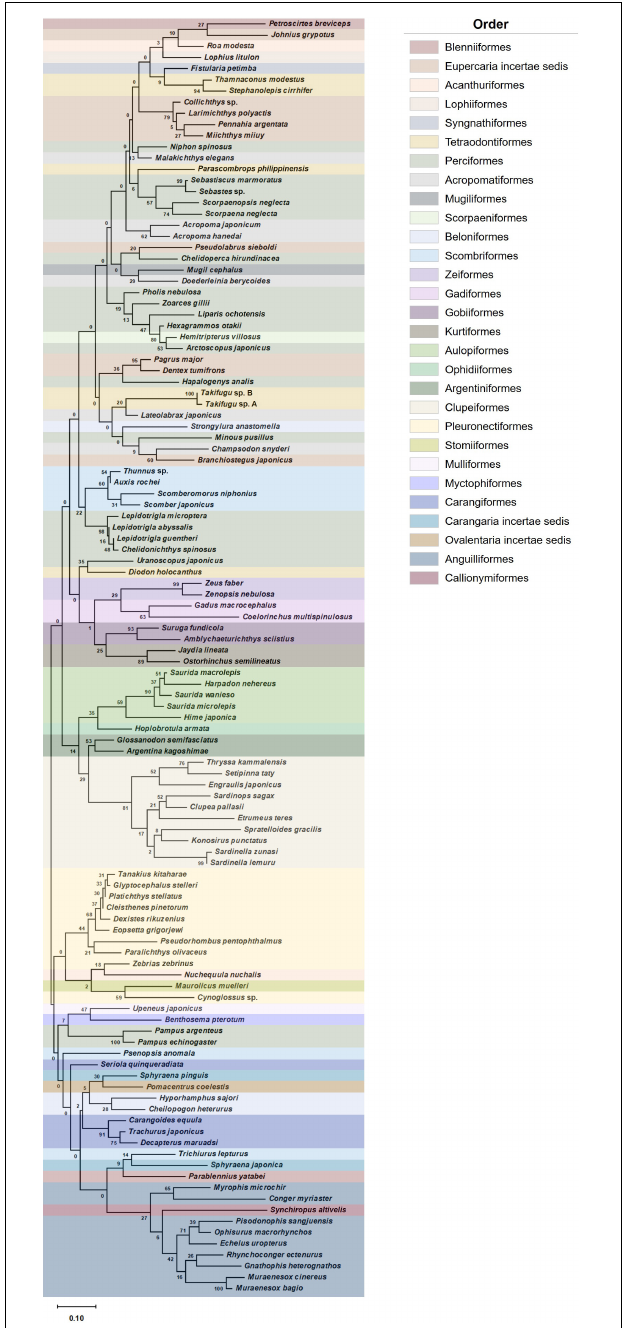
FIGURE 2 | Phylogenetic analysis of representative fish ASVs identified in Korean coastal waters (phylogenetic tree was constructed by maximum likelihood algorithm (MEGA 11.0) under 1,000 replication